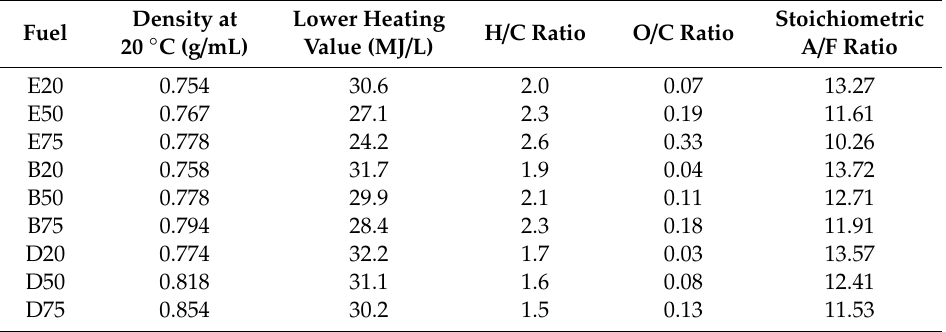
Table 5. Key fuel blend properties. Fuel: ethanol–gasoline blends (E), n-butanol–gasoline blends (B), and 2,5-dimethylfuran–gasoline blends (D) with an E / B / D volume percentage of 20%, and so